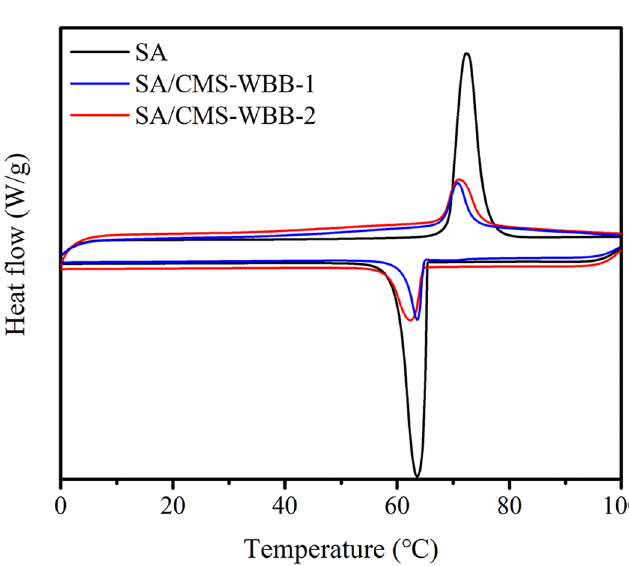
Figure 10. The DSC patterns of SA and SA/CMS-WBB.